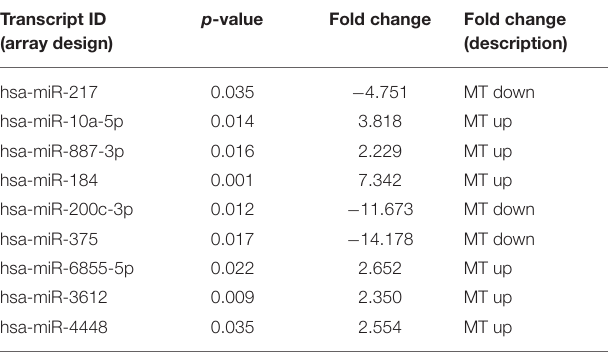
TABLE 2 | MicroRNAs with different expression patterns in localized and metastatic